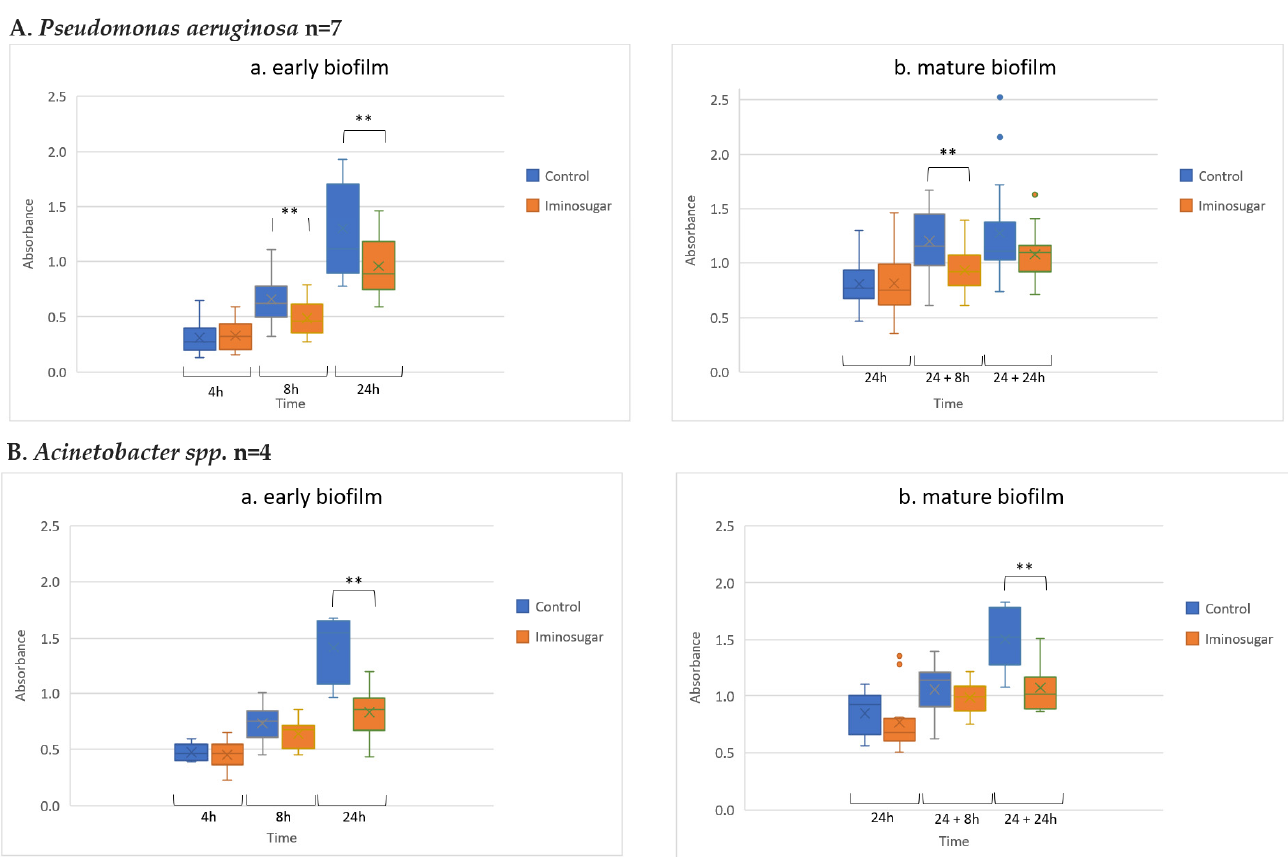
Figure 3. Effect of iminosugar PDIA on biofilm production by selected Gram-negative non-